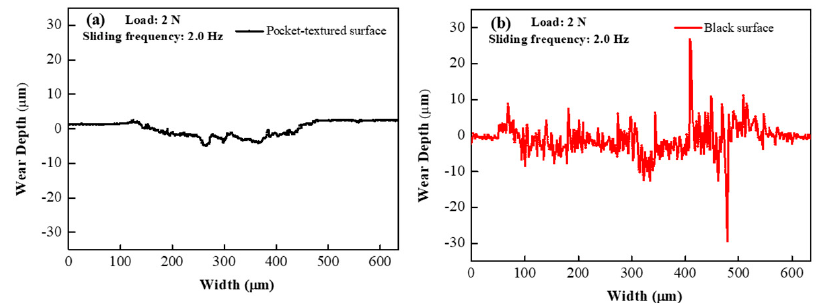
Figure 7. Cross-sectional profiles for ( a ) the pocket-textured surface and ( b ) the blank surface under the load of 2 N and speed frequency of 2 Hz.